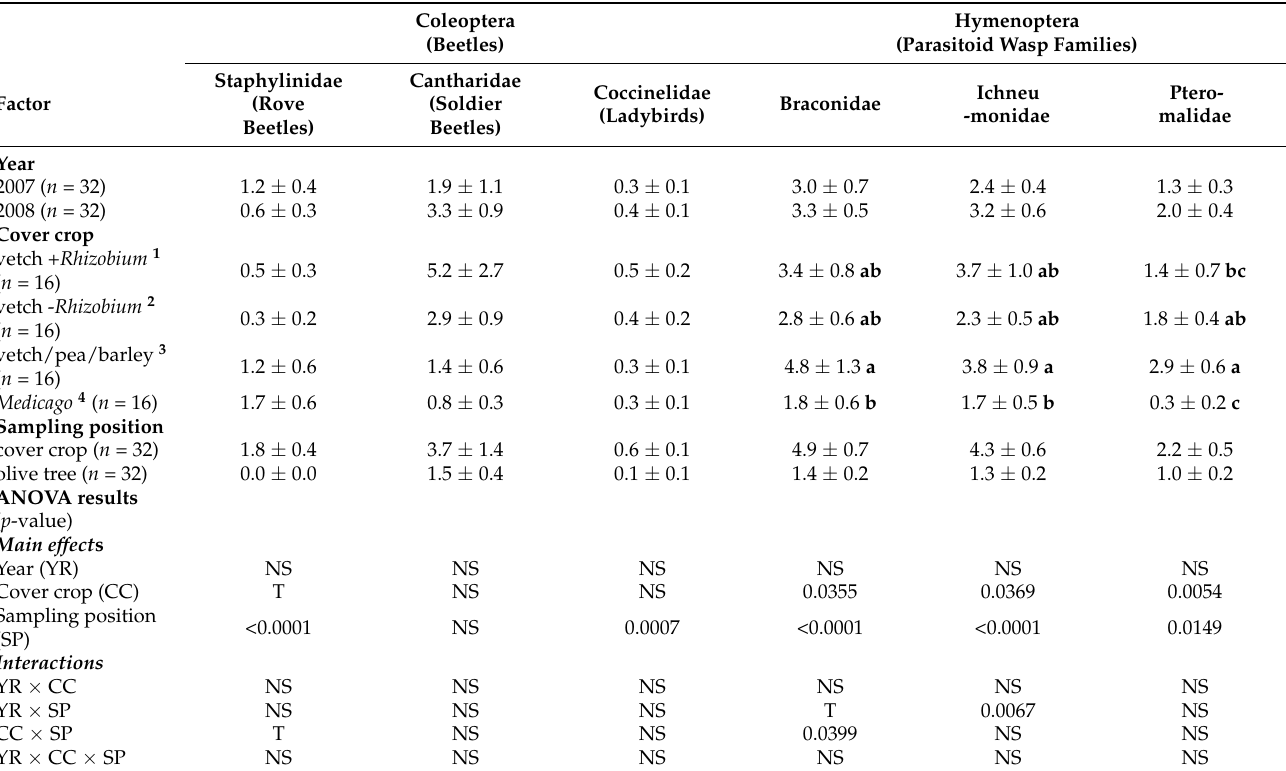
Table 2. Effect of, and interactions between, (a) year (2007 or 2008), (b) cover crop treatment (vetch es- tablished with Rhizobium inoculated seed, vetch established with untreated seed, vetch/barley/pea mixture or Medicago), (c) sampling position (cover crop or olive tree canopy) on the activity (mean numbers of invertebrates collected by suction sampling) of the different invertebrate families belong- ing to the order Coleoptera (beetles) and Hymenoptera 1 in table olive cv Kalamon orchards. Values shown are main effect means ±